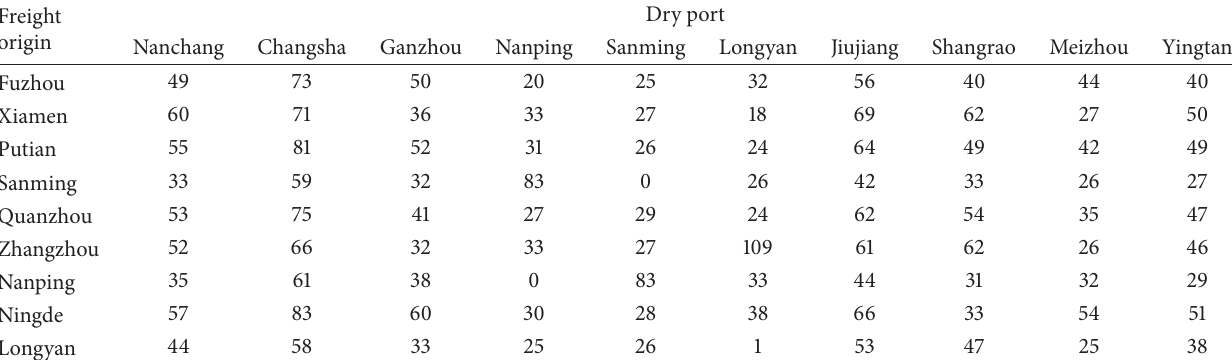
Table 5: Unit transport cost (in Yuan/ton) between cities in Fujian province and alternative dry